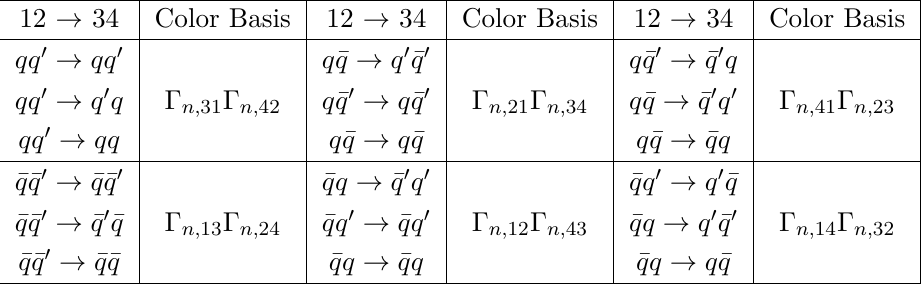
Table 1 . The choice of basis for each of the four quark subprocesses. Γ n,ij are operators in color space which join the fermion lines i and j . For the four quark subprocesses, two operators, Γ 1 ,ij and Γ 2 ,ij , are required to span the color